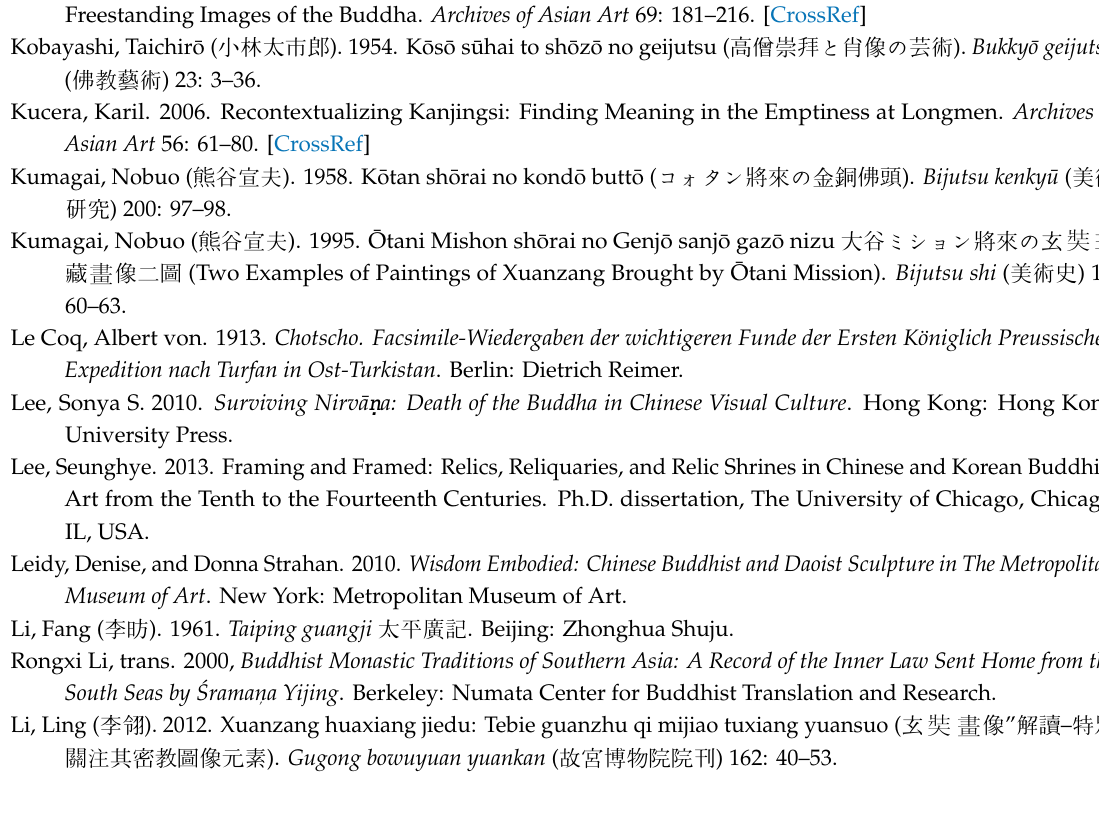
Figure 7. Itinerant Monk . Dunhuang, 10th century. Ink and colors on paper, 51.8 × 29. 3 cm. Inv. No. Dh-320. The State Hermitage Museum, St. Petersburg. Photograph © The State Hermitage Museum,